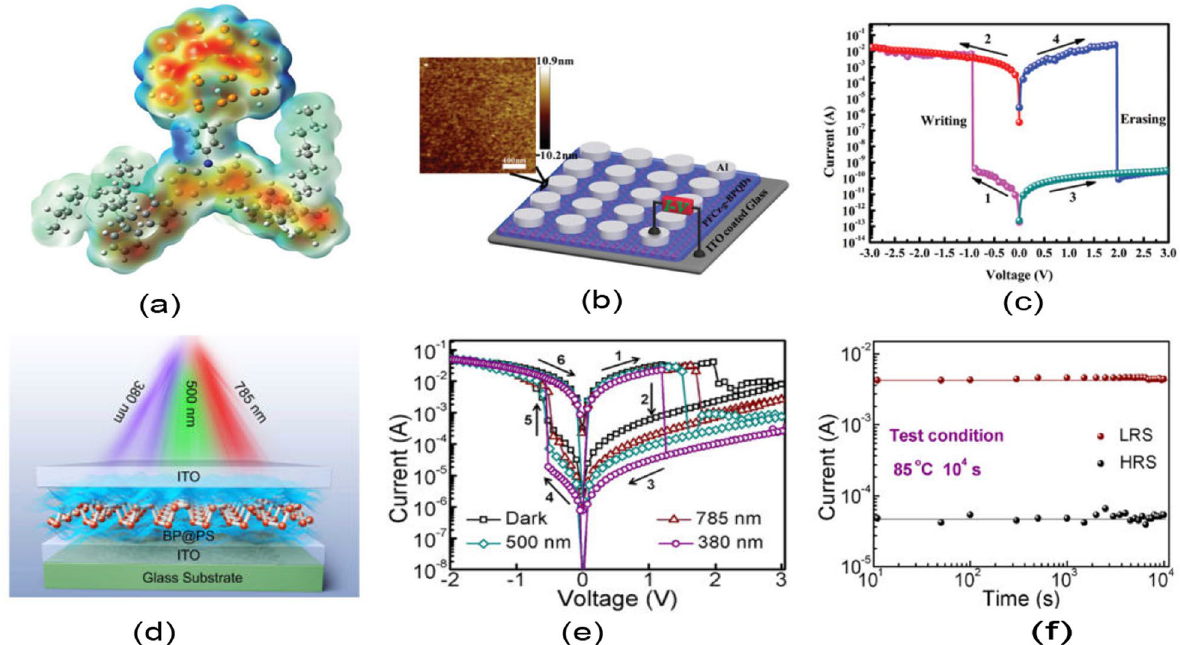
Fig. 25 Schematic and electrical characteristics of the 2D BPQDs-based RRAM devices. a Surface of PFCz-g-BPQDs showing the molecular electrostatic potential (ESP). b Structure of AI/PFCz-gBPQDs/ITO cell with inset showing tapping mode AFM height of the cell. c AI/PFCz- gBPQDs/ITO I–V characteristics. a , b and c show characteristics of PFCz-g-BPQDs device [232]. d Schematic of BP@PS memristor showing light modulation e I–V characteristics of BP@PS memristor as modulated by different wavelengths. f Inset of BP@PS memristor showing its data retention. d , e and f show characteristics of BP@PS memristor [284]